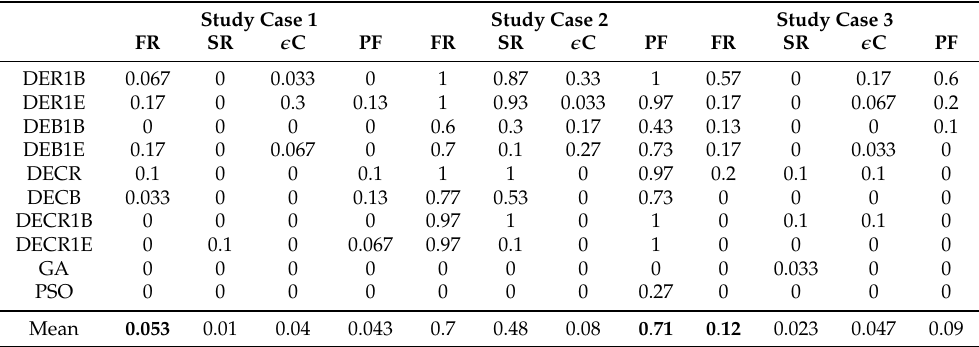
Table A13. The P metric values for each algorithm with the CHTs and the related average values per CHTs for the three study